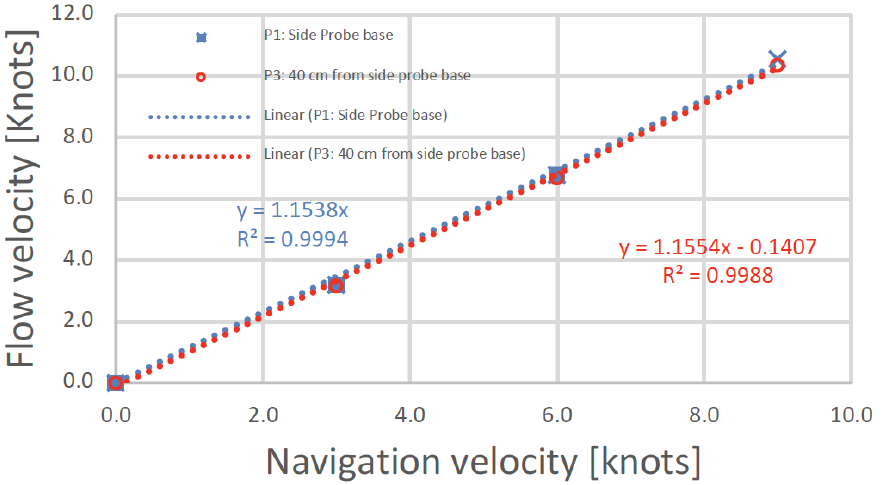
Figure 16. Local flow velocity as a function of navigation speed of a Type 209/1300 submarine at condition 1 at probe base location P1 and measurement protruding probe location P3.